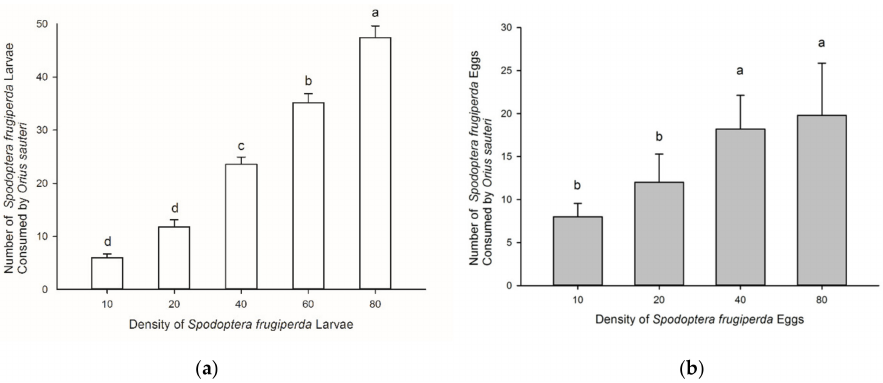
Figure 1. The average predation quantity of 5th instar nymphs of Orius sauteri on 1st instar larvae of Spodoptera frugiperda at different prey densities ( ± SE) ( a ) and the number of eggs consumed at different prey densities ( ± SE) ( b ). Different letters signify significant differences at p <